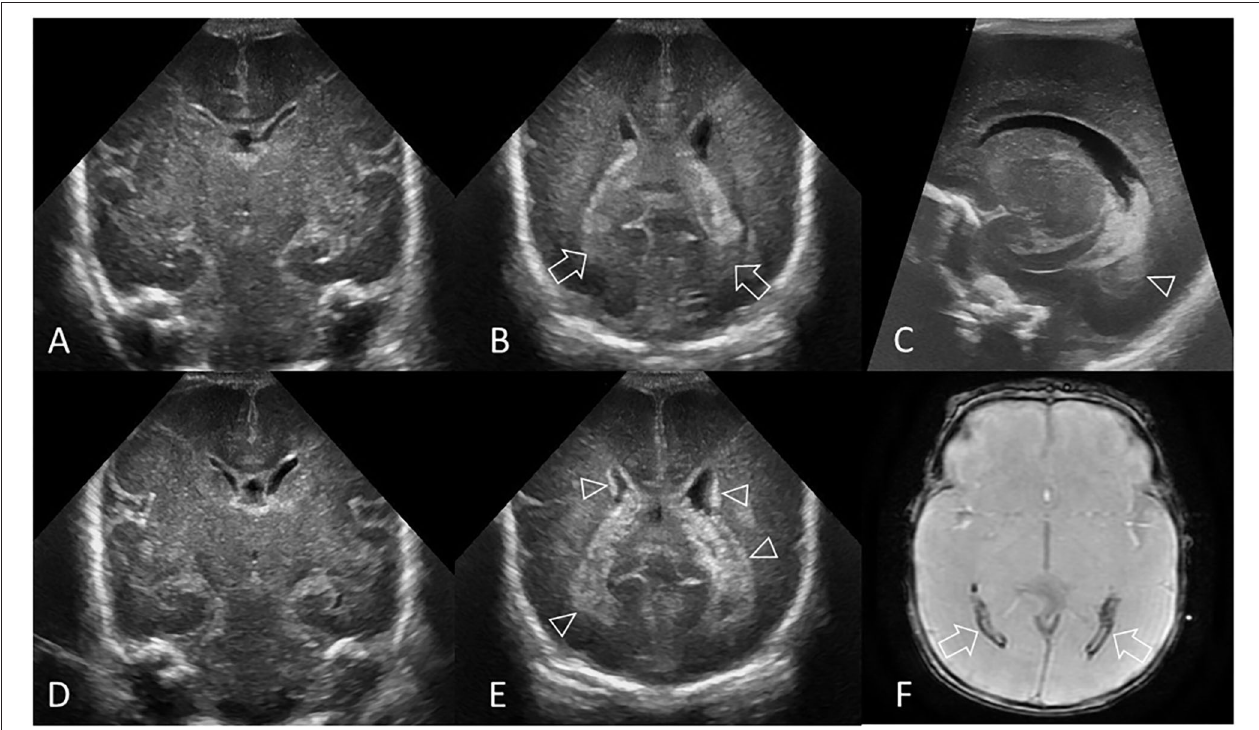
FIGURE 1 | Hyperechogenic ependyma as indirect sign of IVH. Ultrasound and MRI scan in a preterm infant (GA 24 weeks 3 days). (A) Coronal scan at the level of the frontal horns of the lateral ventricles shows no evidence of GMH, IVH, or ventricular enlargement. (B) Coronal scan at the level of the trigone of the lateral ventricles shows a small volume of echogenic clot within the posterior body of both ventricles (arrows); this finding was not recognized at time of original reporting. (C) Parasagittal scan through the left lateral ventricle also shows the small volume IVH (arrowhead). (D) Follow up coronal scan 14 days after birth at the level of the frontal horns still does not show clear evidence of germinal matrix clot. (E) Coronal scan at the level of the trigone of the lateral ventricles shows new hyperechogenic ependyma involving both lateral ventricles (arrowheads), with more extensive IVH within the bodies of the lateral ventricles. No hydrocephalus has developed. The presence of this hyperechoic ependyma on the follow-up scan facilitated a retrospective diagnosis of grade II GMH-IVH in this infant. (F) Axial T2 * gradient-echo MR image 3 months after birth shows increased susceptibility effect (hypointense signal) that outlines the occipital horns of both lateral ventricles (arrows) from hemosiderin/ferritin and confirms presence of earlier IVH. Several microhemorrhages were also identified in the bilateral germinal matrix regions on this blood sensitive MR sequence (not shown).